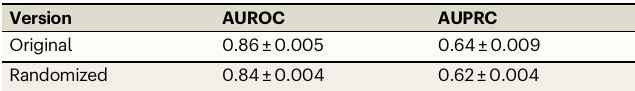
Table 3 | Assigning SMILES and amino acid sequences